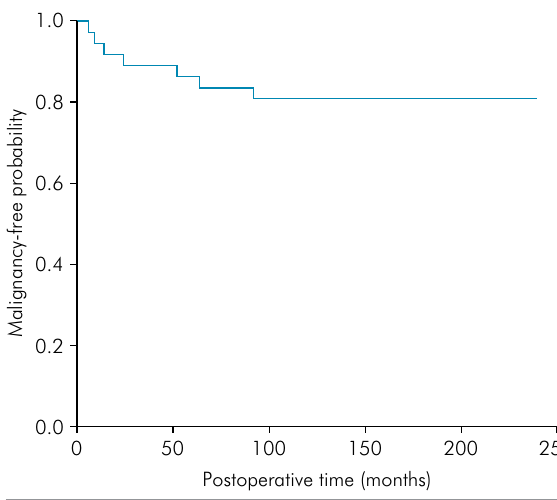
Figure 2. Kaplan–Meier curve for recurrence outcomes Figure 3. Kaplan–Meier curve for malignancy outcomes